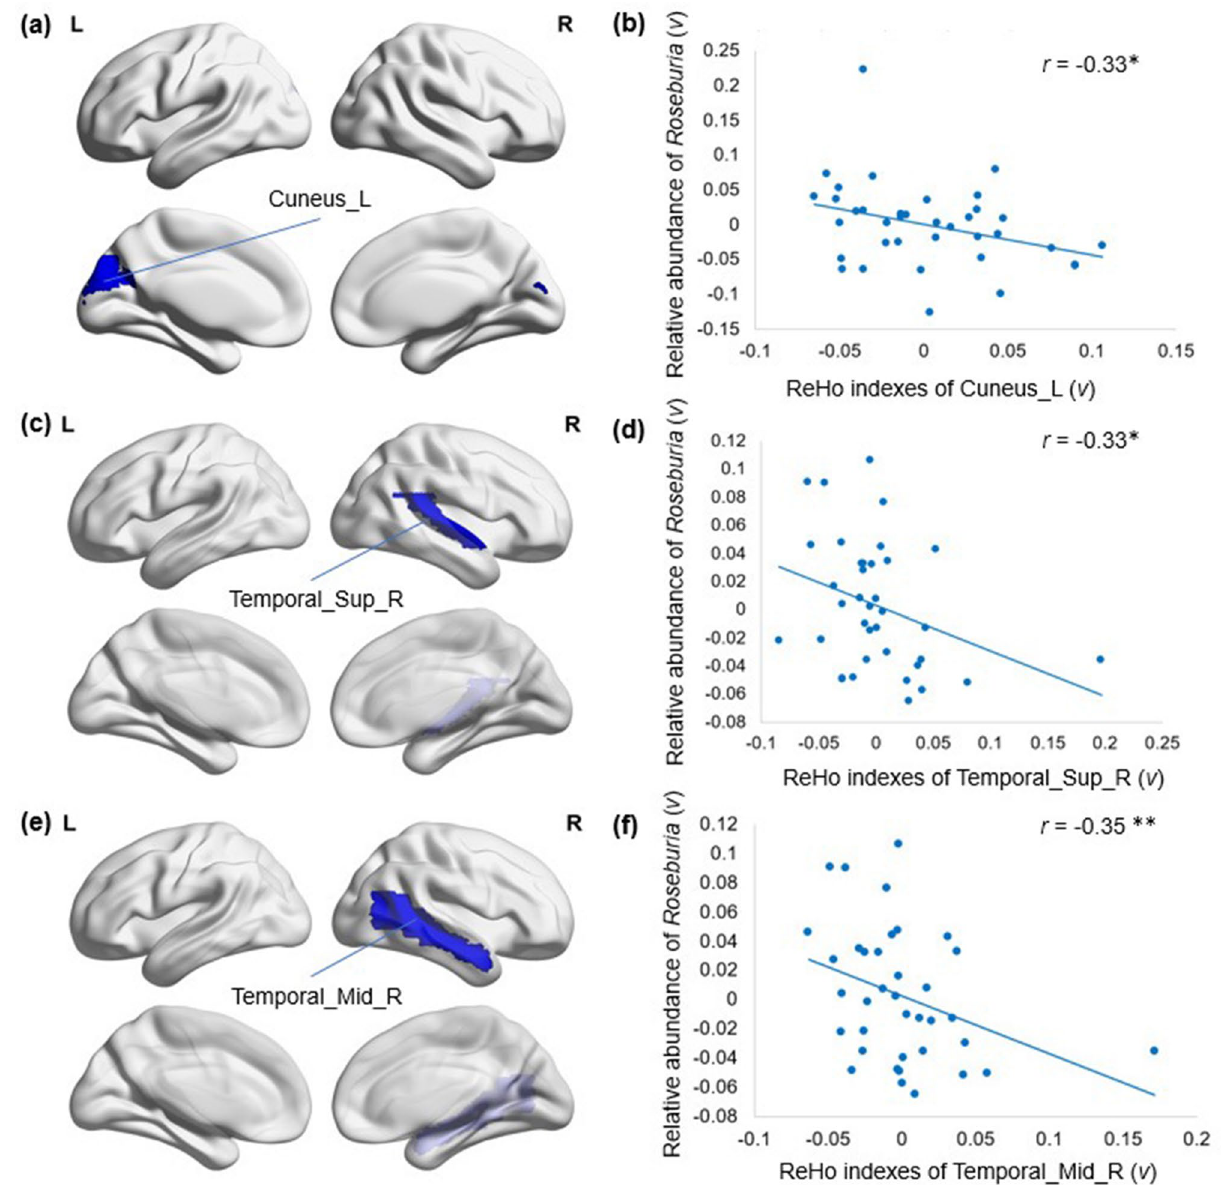
Figure 4. Relative abundance of Roseburia in SZ patients showed strong negative correlations with ReHo indexes. ( a ) Cuneus_L showed significantly decreased ReHo indexes in SZ compared with the NCs ( p < 0.05). ( b ) The residuals of the ReHo indexes in Cuneus_L were significantly negatively correlated with the residuals of the relative abundance of Roseburia in SZ. ( c ) Temporal_Sup_R showed significantly decreased ReHo indexes in SZ compared with the NCs ( p < 0.05). ( d ) The residuals of the ReHo indexes in Temporal_Sup_R were significantly negatively correlated with the residuals of the relative abundance of Roseburia in SZ. ( e ) Temporal_Mid_R showed significantly decreased ReHo indexes in the SZ compared with the NCs ( p < 0.05). ( f ) The residuals of ReHo indexes in Temporal_Mid_R were significantly negatively correlated with the residuals of the relative abundance of Roseburia in SZ. Sup: superior; Inf: inferior; L: left hemisphere; R: right hemisphere. ** p < 0.05, FDR corrected, * p = 0.05, FDR corrected. Figure was generated by a brain network visualization tool of “BrainNet viewer” (Version 1.7, https:// www. nitrc. org/ proje cts/ bnv/), based on MATLAB (Version